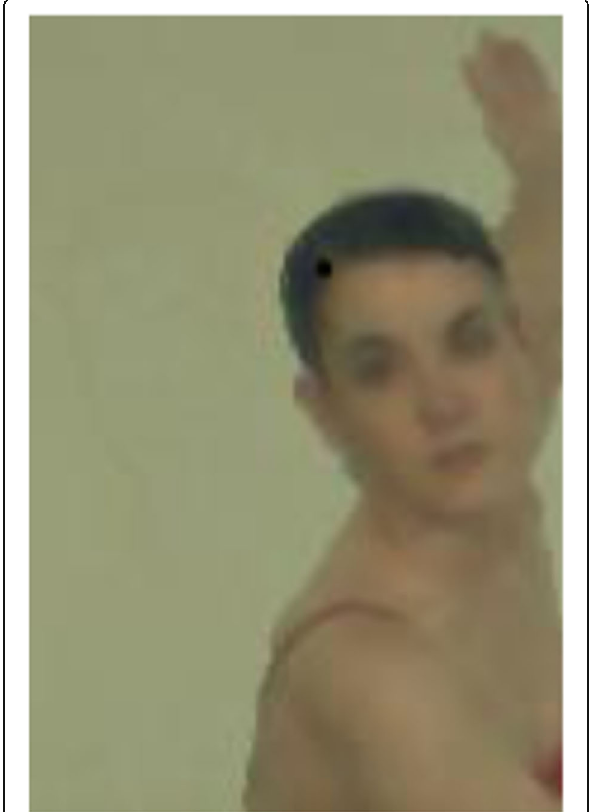
Fig. 6 The virtual view after artifacts